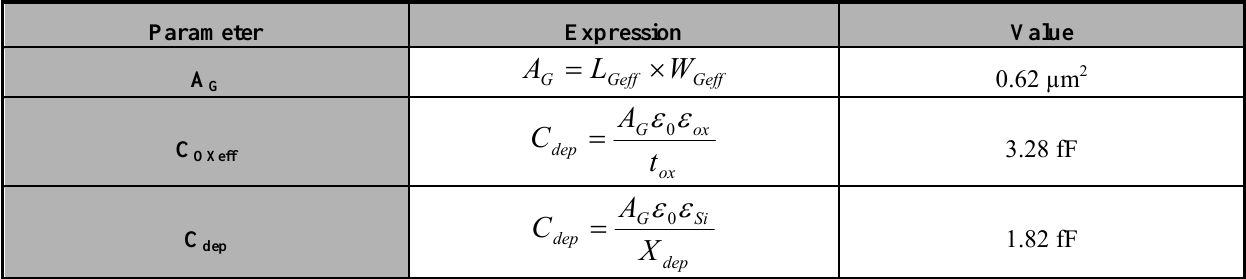
Table 2. Expressions of parameters and evaluated values for a 2.2 µm-pitch 1 T